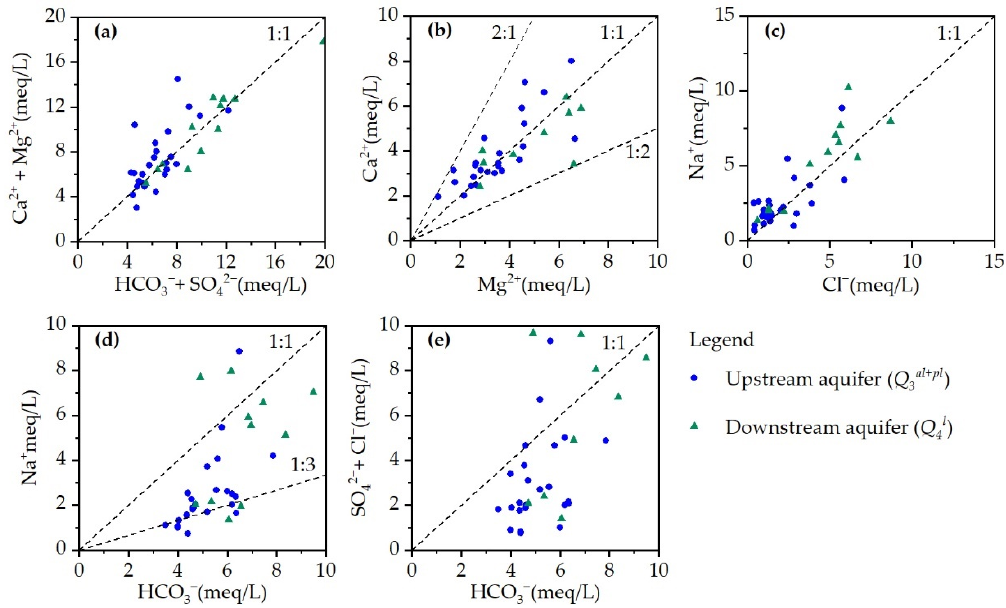
Figure 6. Ion proportional coefficient diagrams: (Ca 2+ + Mg 2+ ) vs. (HCO 3– + SO 42 − ) ( a ), Ca 2+ vs. Mg 2+ ( b ), Na + vs. Cl − ( c ), Na + vs. HCO 3 − ( d ), and (SO 42– + Cl – ) vs. HCO 3 − ( e ).